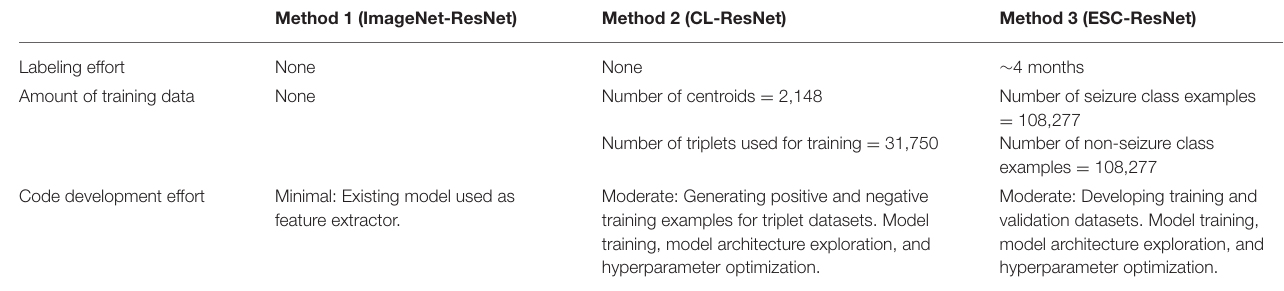
TABLE 1 | Development effort for the 3 non-linear iEEG embedding methods explored.